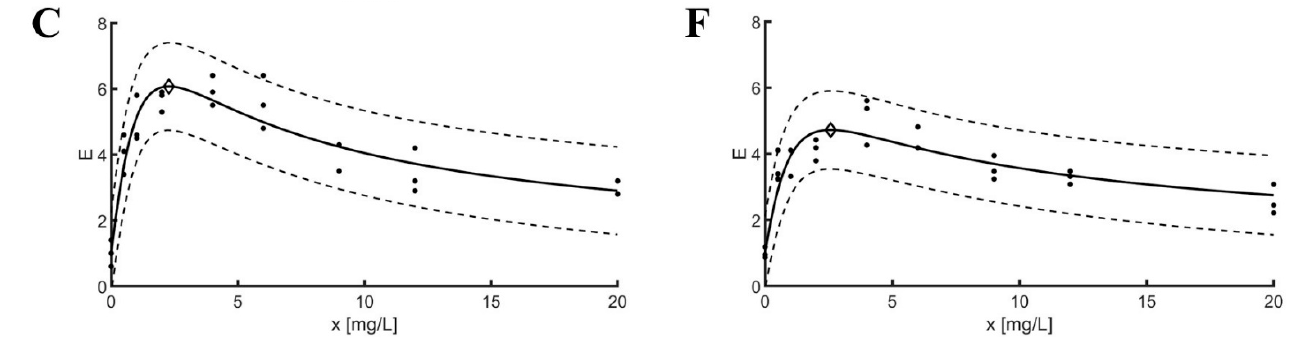
Figure 2. Brian and Cousens model curve adjustment for ST test. ( A ) Curcumin—Balb3t3; ( B ) Resveratrol—Balb3t3; ( C ) Baicalin—Balb3t3; ( D ) Curcumin—L929; ( E ) Resveratrol—L929; ( F ) Bai- calin—L929. Table 3. Estimated Brian and Cousens model parameters and values of maximum relative effects for ST tests. Parameters Goodness of